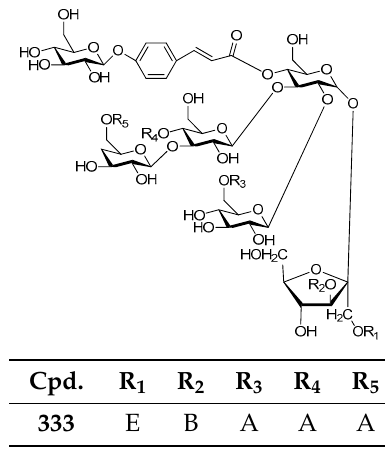
Cpd. Figure 70. Structures of compounds 331 – 332 . Figure 70. Structures of compounds 331 – 332 . Figure 70. Structures of compounds 331 – 332 . Figure 70. Structures of compounds 331 – 332 .